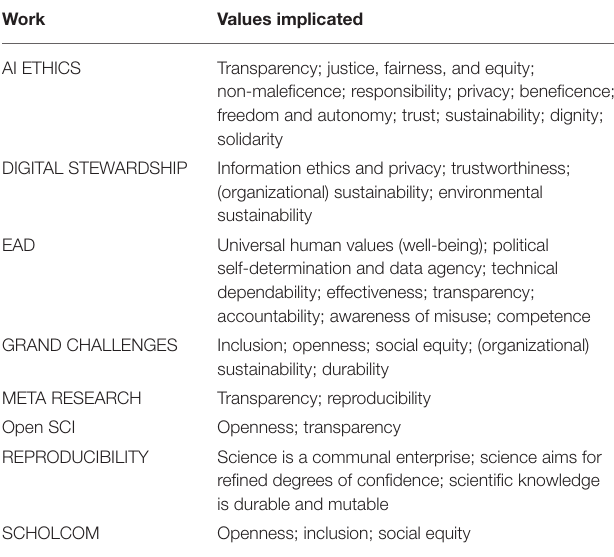
TABLE 3 | Core values and principles identified in each